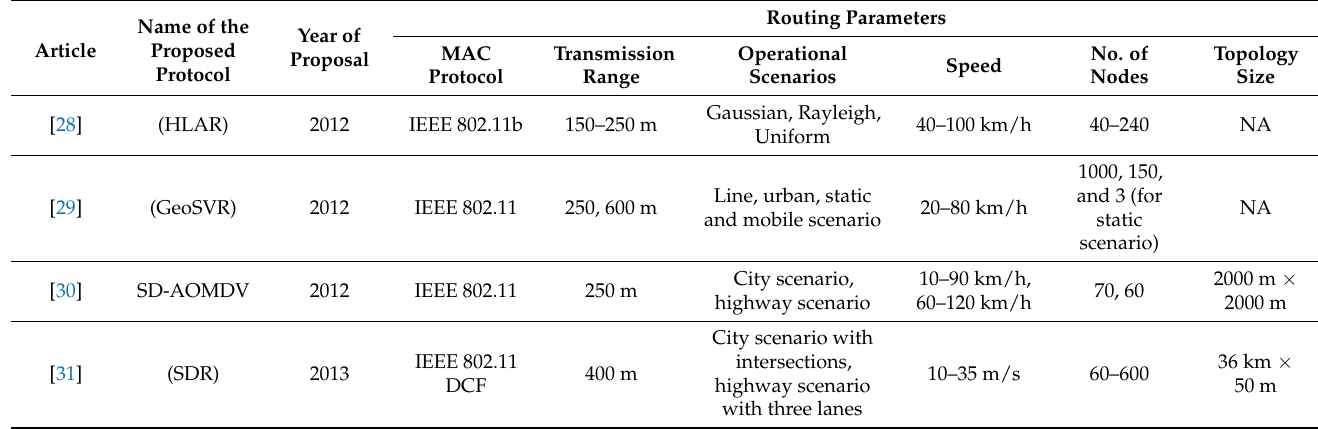
Table 5. Routing parameters of hybrid scenario-based routing protocols.